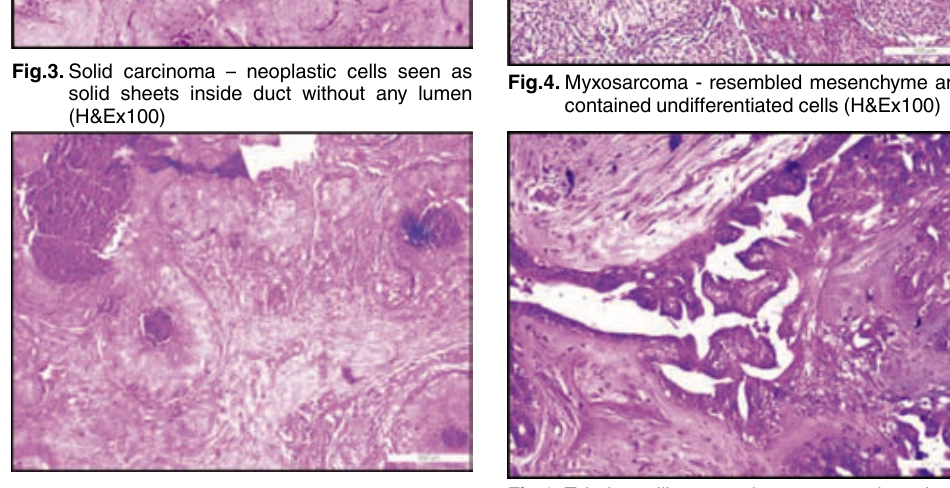
Fig.6. Tubulopapillary carcinoma – pedunculated or sessile papillae extending into lumen